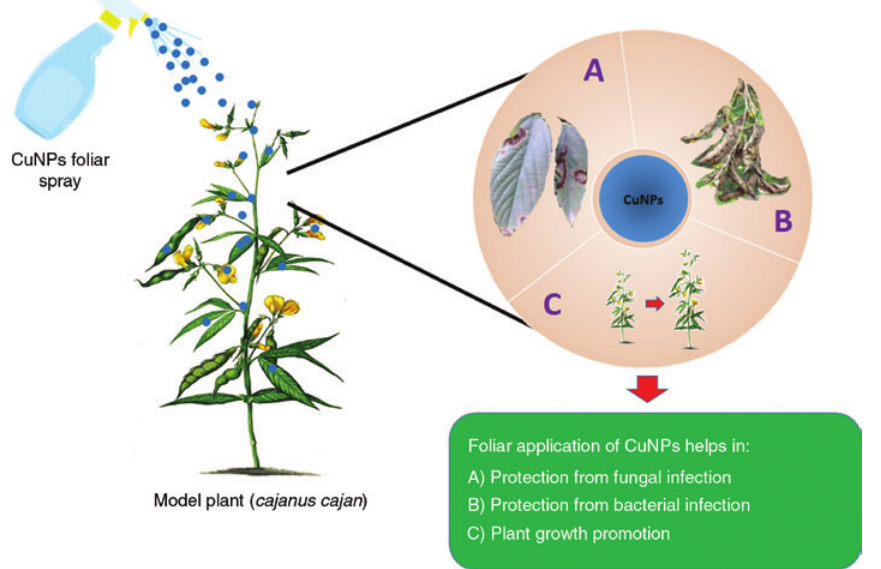
Figure 1: Schematic illustration of CuNPs application for protection of plants and its growth promotion. CuNPs provide protection to crop plants against (A) fungal infections (B) bacterial infections (C) by promoting plant